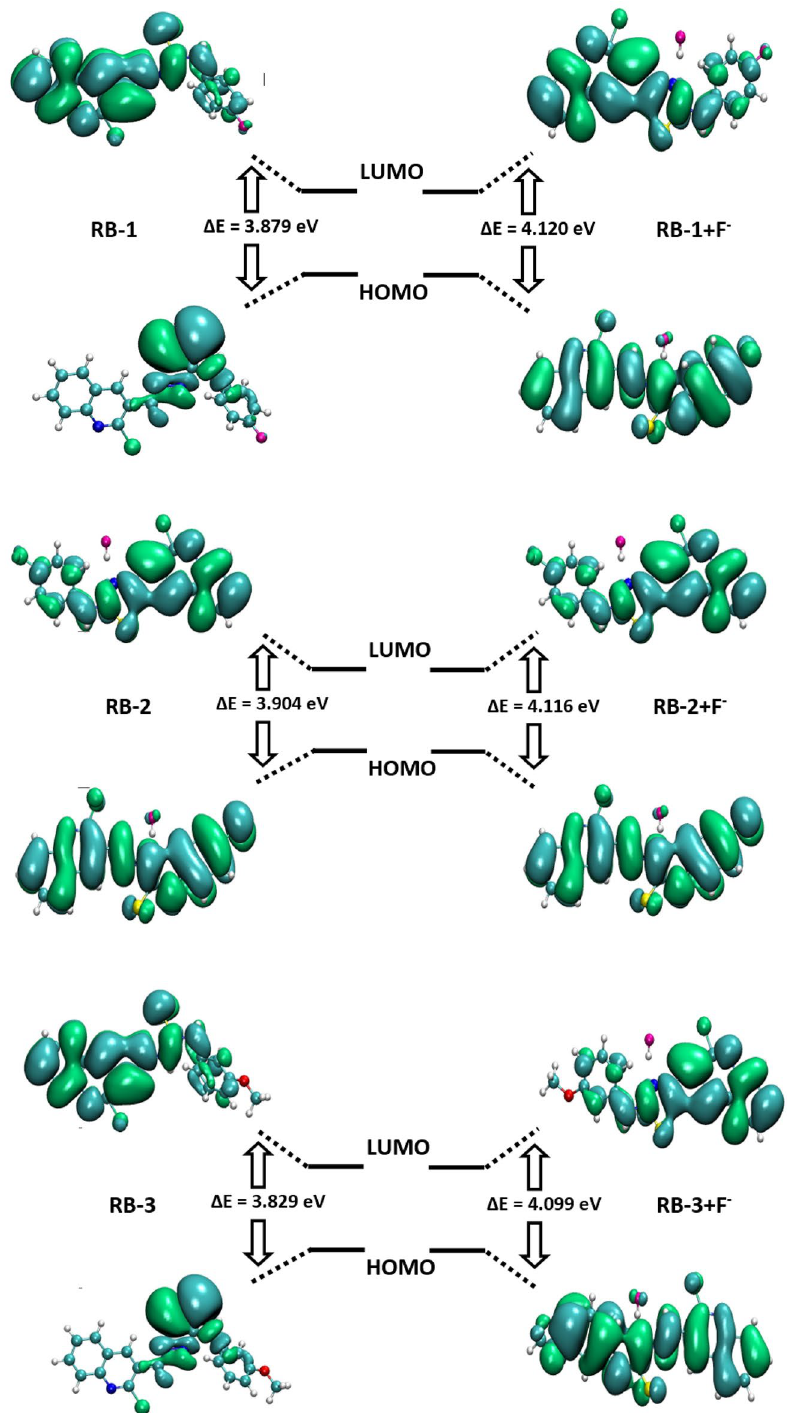
Figure 9. FMOs of RB-1, RB-1 + F − , RB-2, RB-2 + F − , RB-3, RB-3 + F −